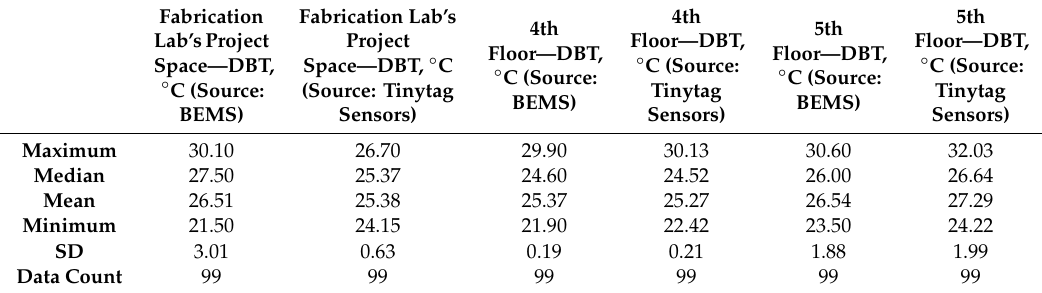
Figure 10. Validation and Deviations between BEMS and Tinytag data in ( a ) Project Space, ( b ) 4th Floor and ( c ) 5th floor. Table 2. Descriptive Statistics of recorded data from BEMS and Tinytag Sensors.